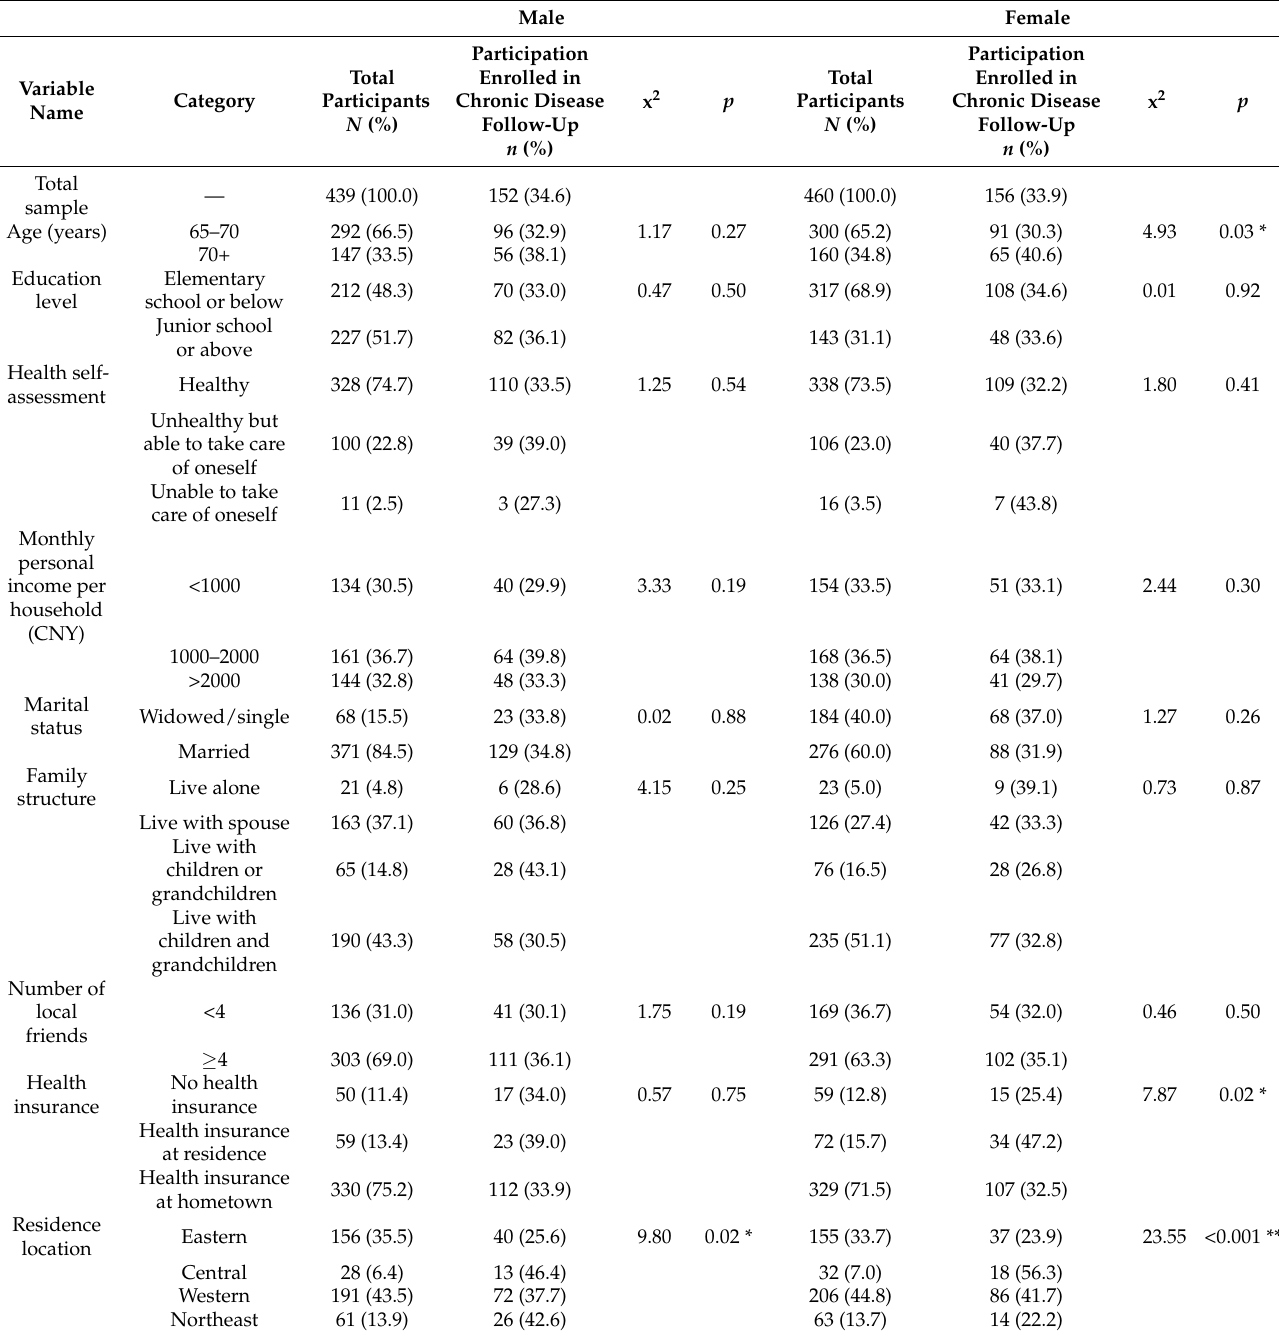
Table 3. Participants’ characteristics in terms of enrolment in the chronic disease follow-up among older migrants ( N = 899). Male